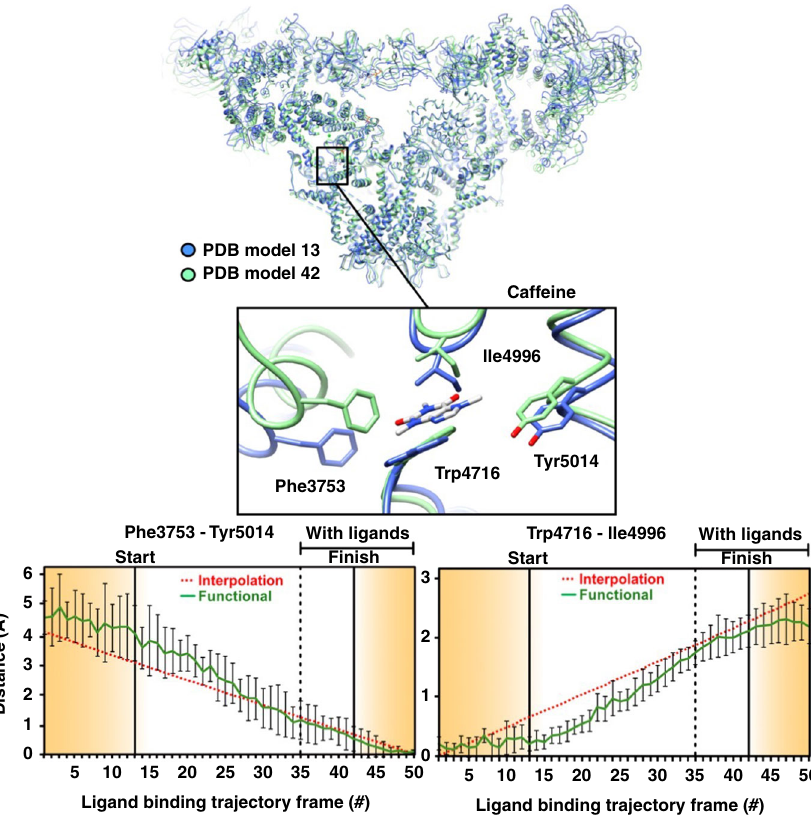
Fig. 3 Conformational changes at the caffeine binding site along the functional path. Ryanodine receptor 1 (RyR1) conformational changes at the caffeine binding site along the functional trajectory of Fig. 1a, augmented with excursions from the minimum-energy points along CC1. These excursions are in the increasing CC1 direction on the no-ligand landscape, and in the decreasing CC1 direction on the with-ligand landscape. Top: The general region and the speci fi c site (inset) are examined in detail. The molecule is shown in blue ribbon for the model corresponding to “ START ” , and in green ribbon for model corresponding to “ FINISH ” in Fig. 1a. Bottom: Distance variations between two pairs of amino acid backbones on the opposite side of caffeine. The amino acids used for measurement are represented as sticks. Error bars represent the full scatter (not standard deviation) of the results obtained with six different starting